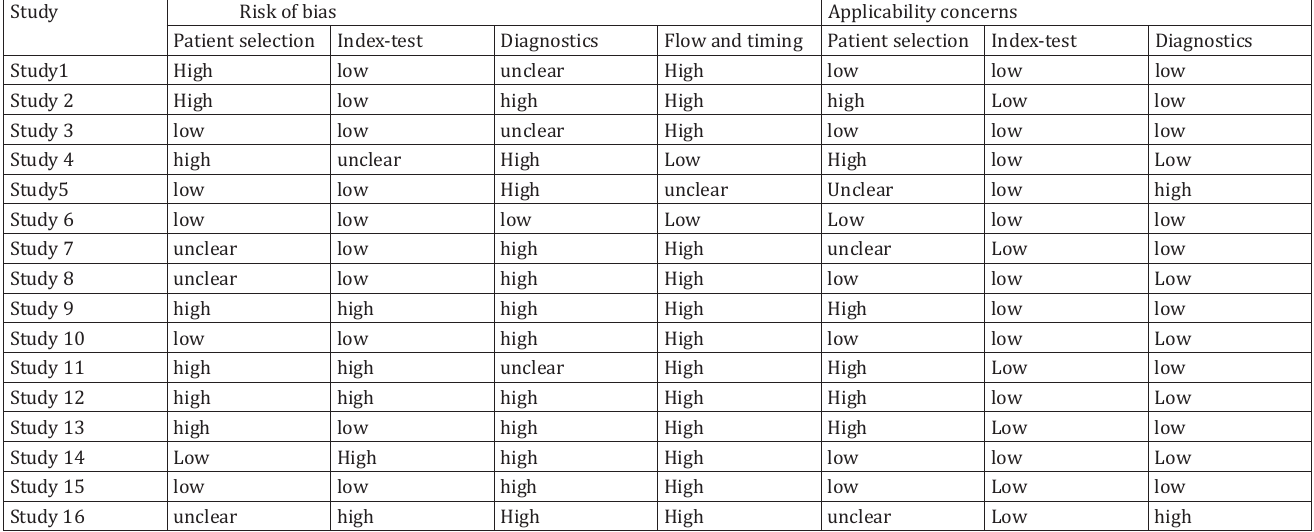
Risk of bias in studies evaluating the validity and reliability of the tool, as well as applicability concerns to review the question of screening for the presence of ASD